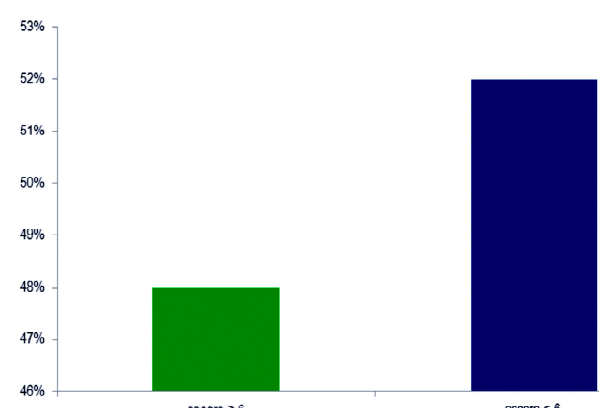
Fig. 2 - Porcentagem de mortalidade hospitalar em comparação com escore 4Ts. X 2 Tendência linear. (P <